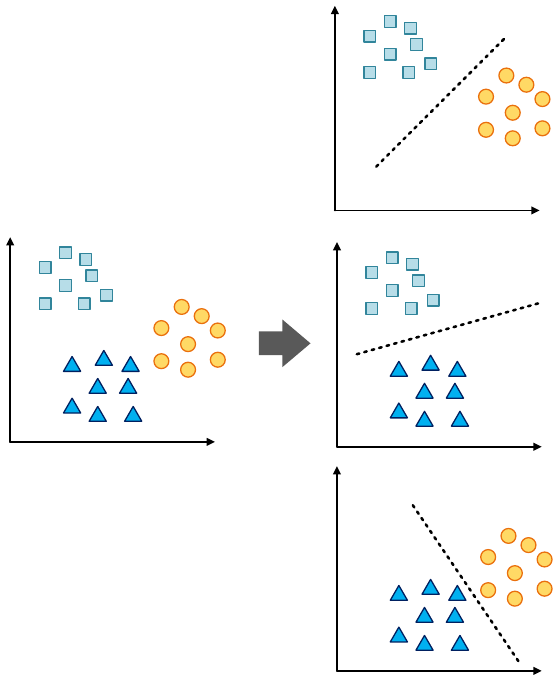
Figure 14. One-vs-one multiclass classification technique principle.